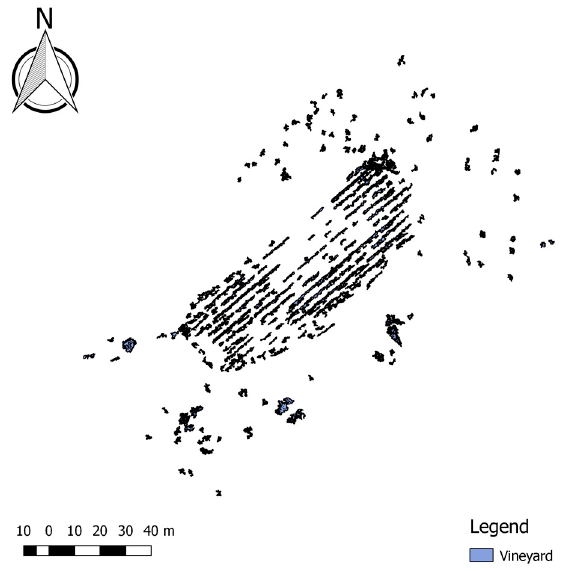
Figure 12. Vineyard crop result.